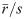
Performance of portfolios.On y-axis we have taken r¯/s (averaged over all 47718 portfolios ~ 1 year, 2014) and on x-axis 240 time ticks corresponding to 30second, 1 minute, 1.5 minute…240 minutes, from the time of investments. Green colour plus (+): Markowitz portfolio consisting of 45 stocks which maximizes Sharpe ratio using exponential weighted correlation; Blue colour circle (o): Markowitz portfolio consisting of 45 stocks which maximizes Sharpe ratio using simple correlations; Black colour square (∎): mutual information based portfolio consisting of 5 peripheral stocks; Red colour triangle (⊿): correlation based portfolio consisting of 5 peripheral stocks; Cyan colour cross (*): exponential weighted correlation based portfolio consisting of peripheral stocks; (a) comparison based on 3 peripheral stocks (b) comparison based on 5 peripheral stocks (c) comparison based on 10 peripheral stocks.